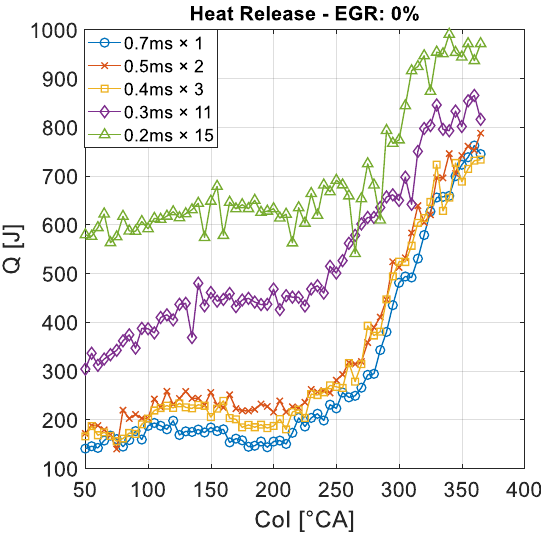
Figure 4. The heat release of the investigated structures with the same dose in the function of CoI without EGR.